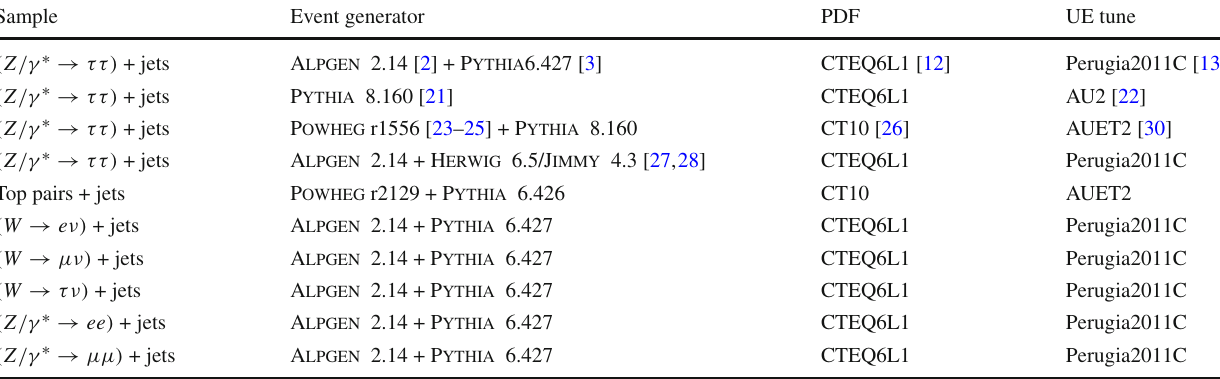
Table 1 Simulated event samples used in the analysis. The table lists the sample, the event generator, the PDF set, and the underlying-event tune